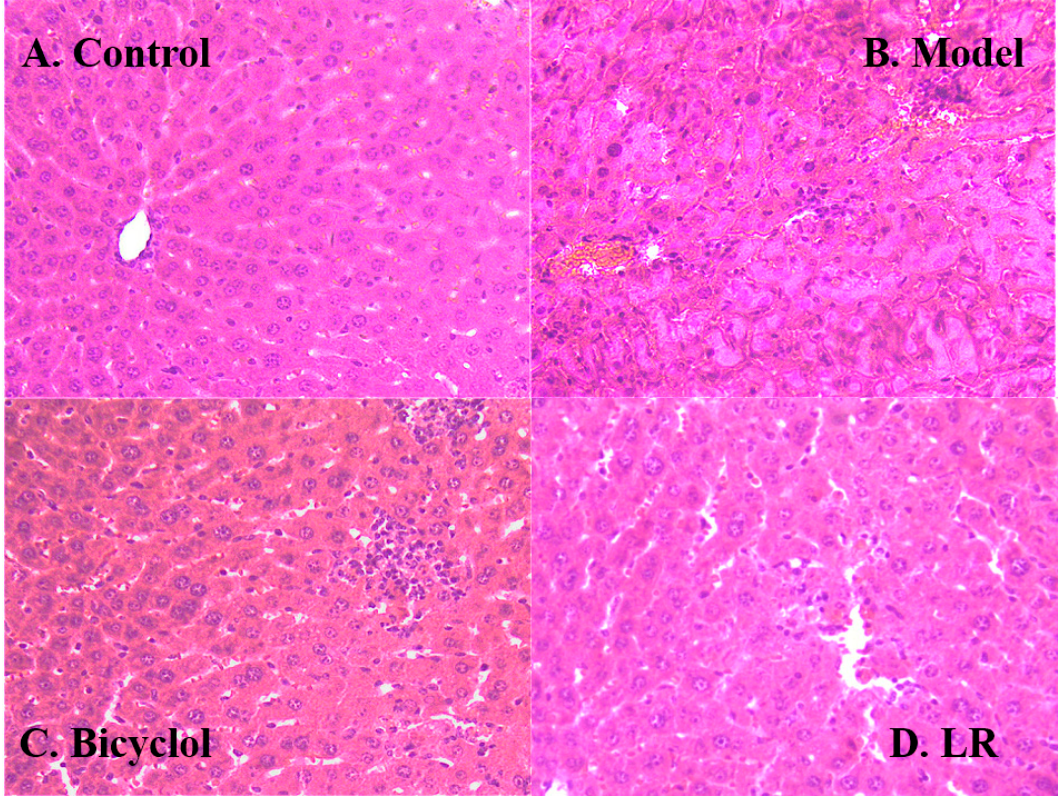
Figure 2. Representative hematoxylin and eosin (HE) stained sections (200×) of the liver of mice from the groups of control ( A ), model ( B ), bicycle ( C ), and LR ( D ).